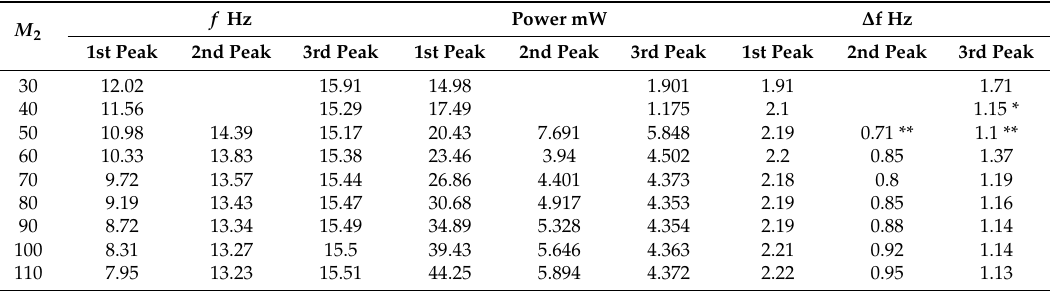
Table 8. Three bimorphs system—the influence of the middle mass, M 2 .